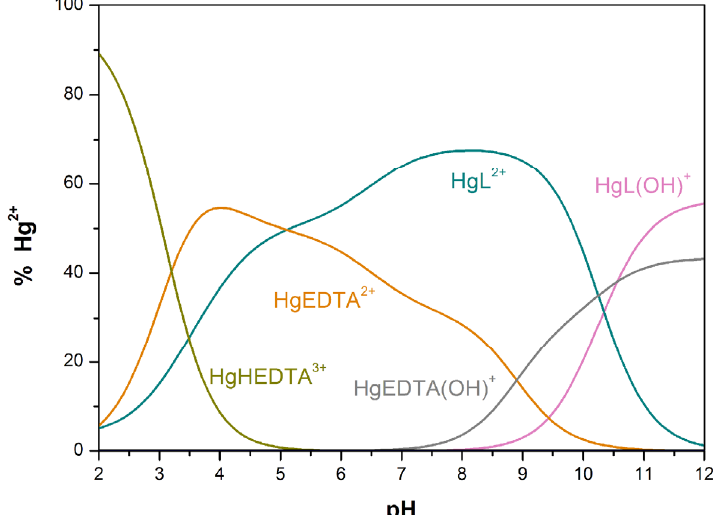
Figure 3. Species distribution curves calculated for an aqueous solution containing [15]aneN S (L), Hg 2+ and EDTA at 0.75:1:1 molar ratio. Percentages are given relative to 4 Hg 2+ at an initial value of 1.73 × 10 − 3 M.